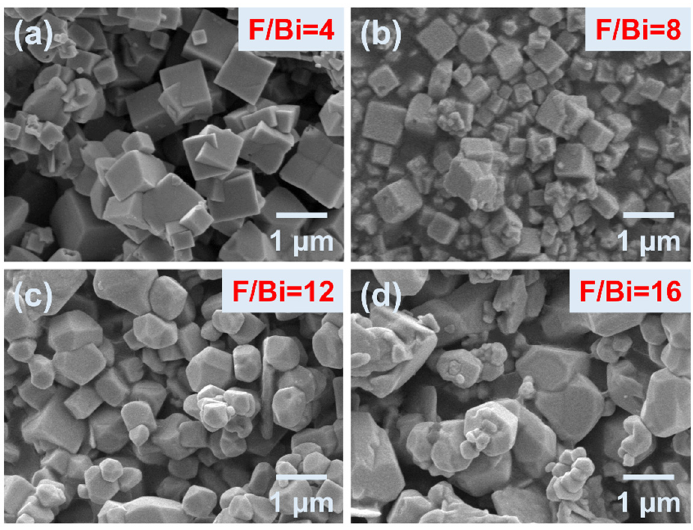
Figure 3. SEM photographs of the pure KBF nanocrystals synthesized at different ratios of F/Bi, ( a ) F/Bi=4; ( b ) F/Bi=8; ( c ) F/Bi=12; ( d ) F/Bi=16.